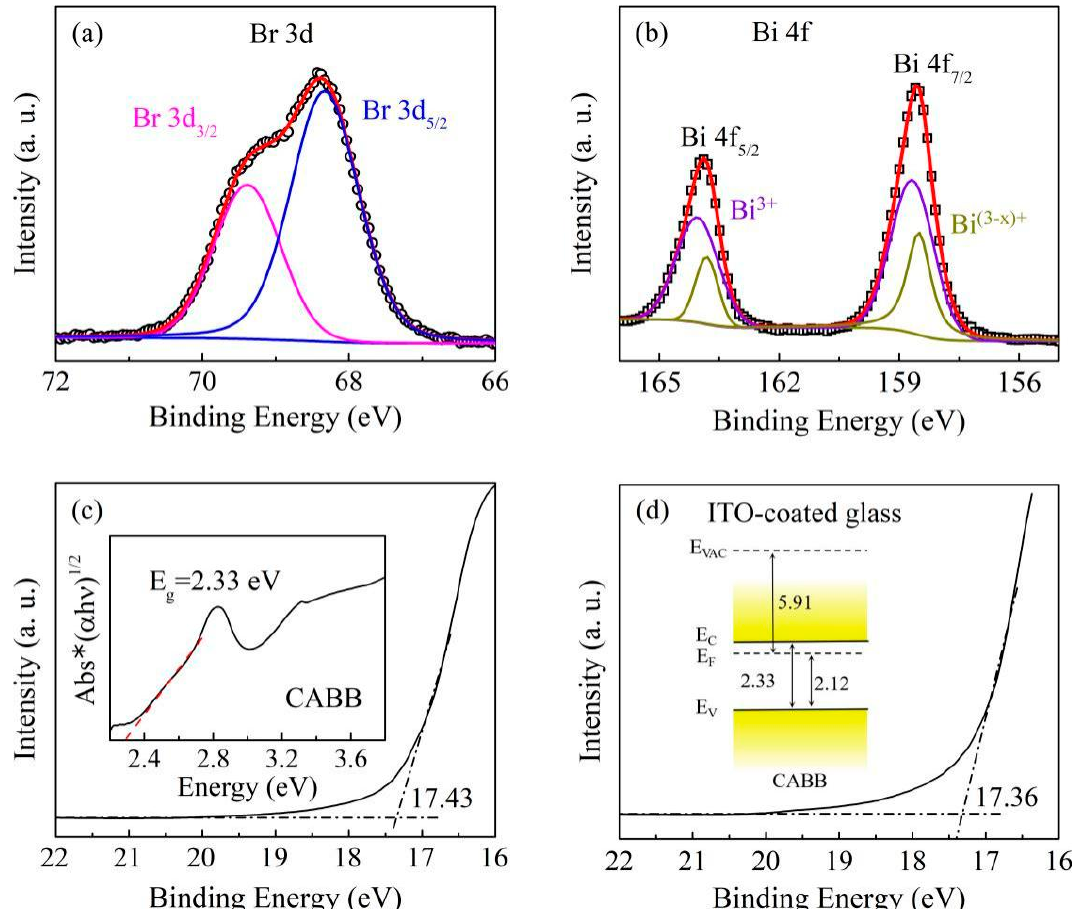
Figure 5. The core-level spectra of ( a ) Br 3d and ( b ) Bi 4f with peak fittings. ( c ) The UPS spectrum of the CABB film at the cut-off region measured by the He I source ( h ν = 21.22 eV). The inset is the Tauc plot obtained from UV–Vis spectroscopy. ( d ) The cut-off region of the ITO-coated glass. The inset is a schematically illustrated band diagram of the CABB film.